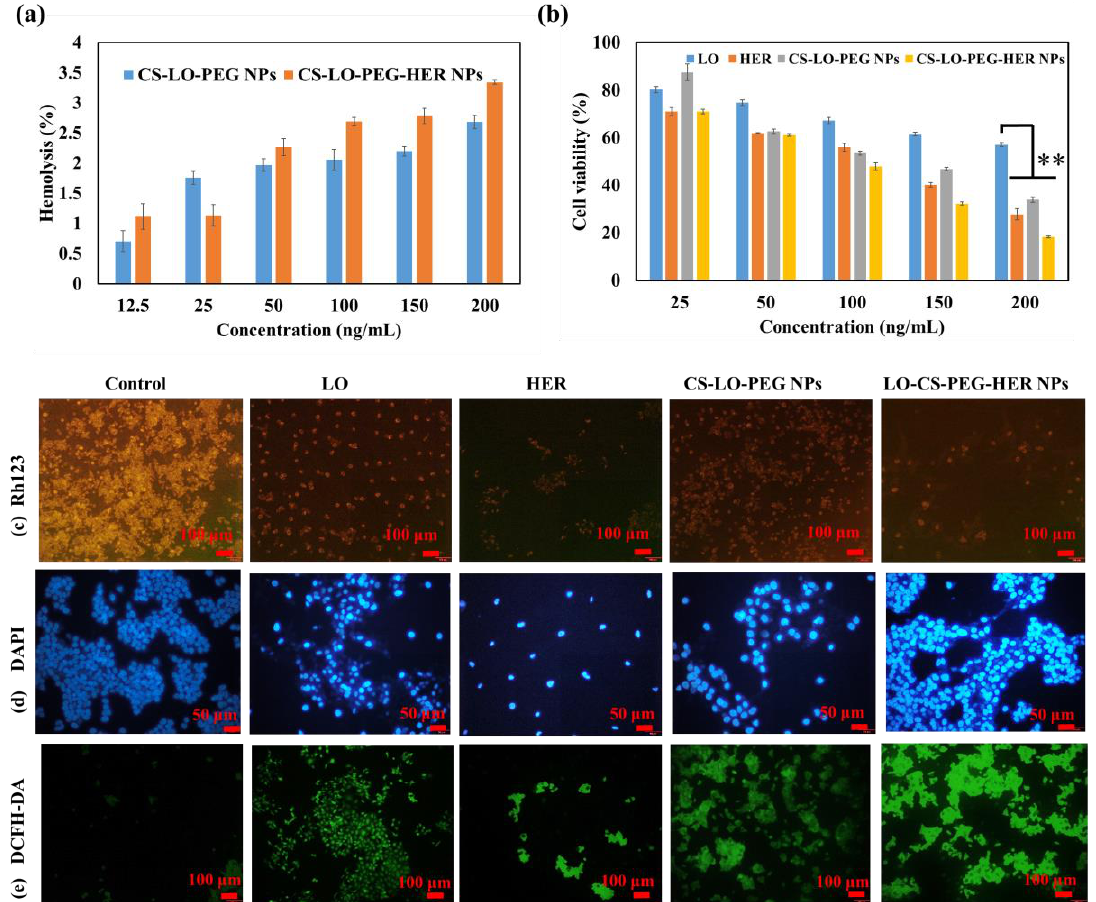
Figure 4. Blood compatibility of CS-LO-PEG-HER NPs and CS-LO-PEG- NPs ( a ), cytotoxicity of enzyme loaded nanoparticles in BT474 cell line ( b ), microscopic fluorescent analysis of enzyme or enzyme loaded nanoparticles induced mitochondrial membrane loss by Rh123 ( c ), nucleus damage by DAPI ( d ), reactive oxygen species generation by DCFH-DA ( e ). Where CS is chitosan, LO is L-lysine α -oxidase, PEG is polyethylene glycol 600, HER is herceptin (Trastuzumab). ** p < 0.01.